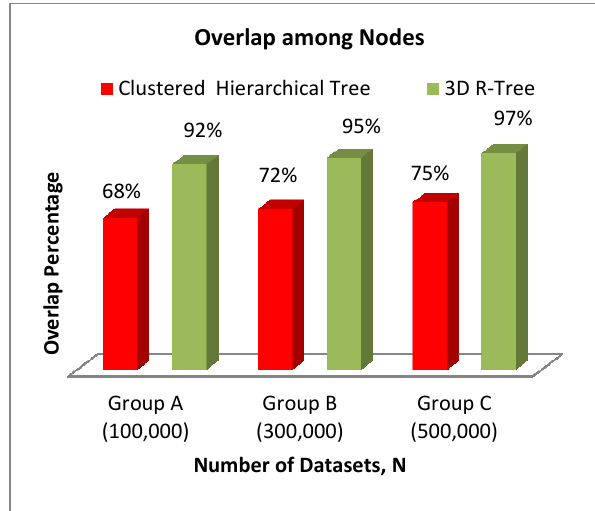
Figure 4. Overlap percentage analysis for varying number of datasets (Azri et al., 2015)